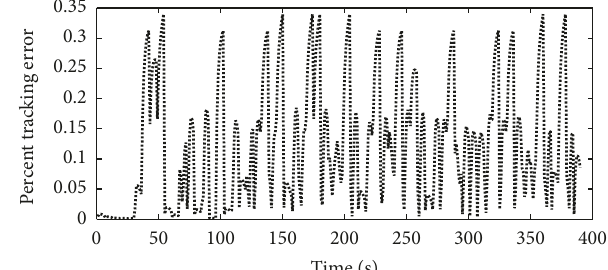
Figure 11: Percent tracking error for a mission with a 6-second turn